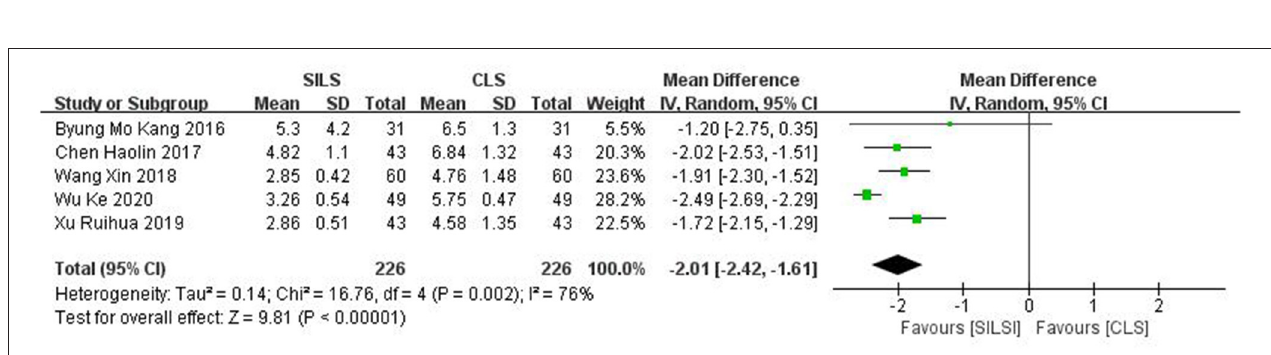
FIGURE 3 | Meta-analysis of intraoperative complications. SILS, single-incision laparoscopic surgery; CLS, conventional laparoscopic surgery.